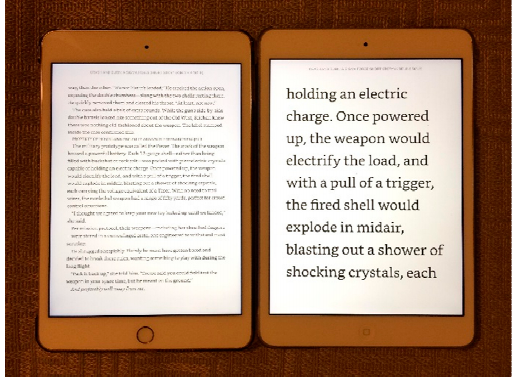
Figure 9. Tablets provide an easy way to produce large print.